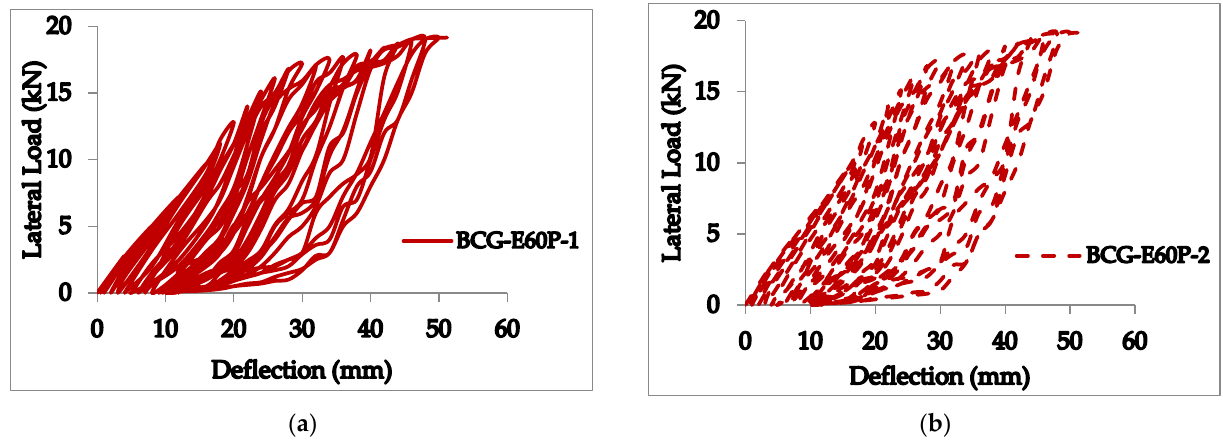
Figure 10. The hysteretic curve of the GFRP-ECC60P beam-column. ( a ) Specimen 1; ( b ) specimen 2.